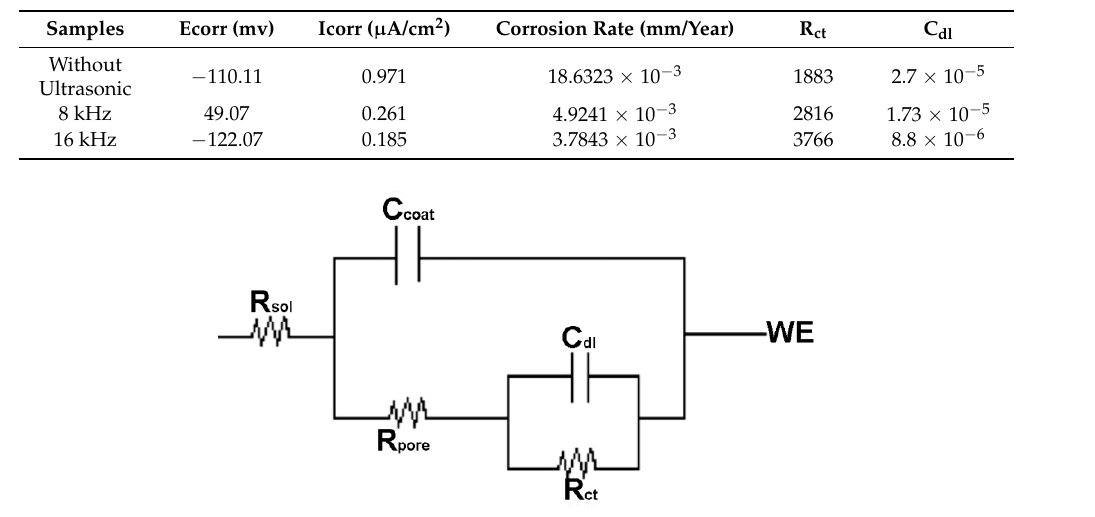
Figure 7. Equivalent circuit to fit electrochemical impedance data.